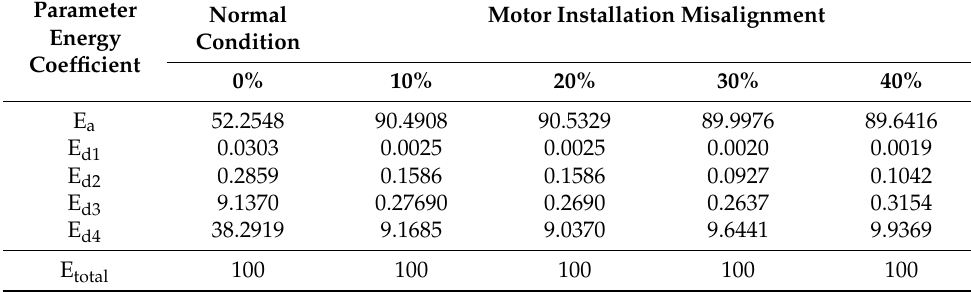
Table 3. The analysis results of the motor current signal energy coefficient.